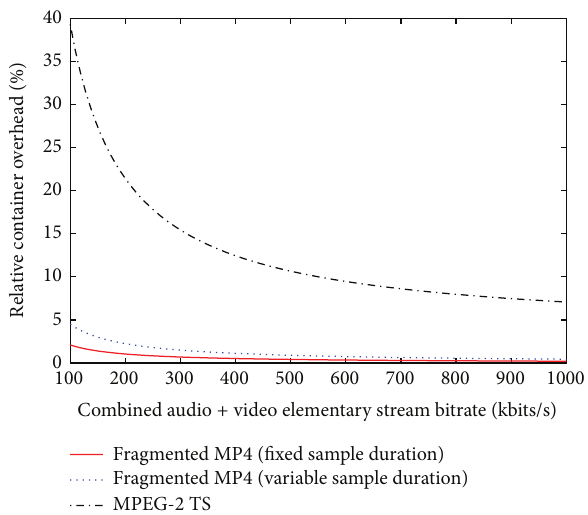
Figure 13: Relative media container overhead as a function of the elementary stream bitrate in a stream with 50 presentation units per